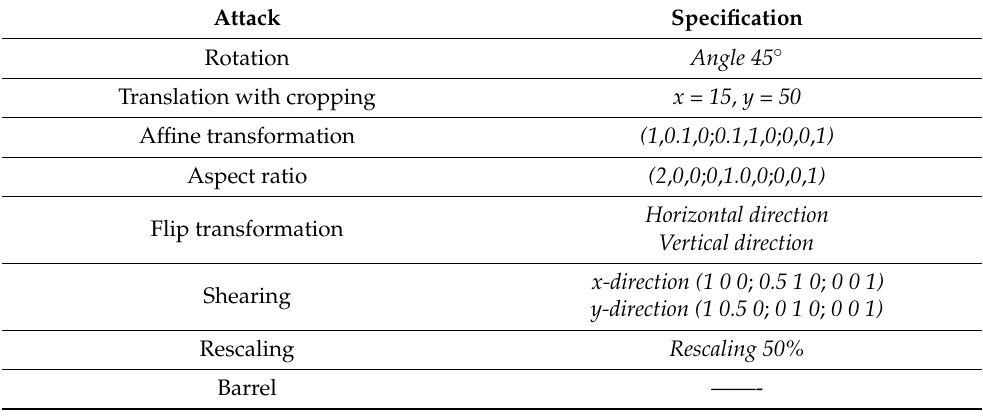
Table 1. Common geometric attacks used to the experimental.